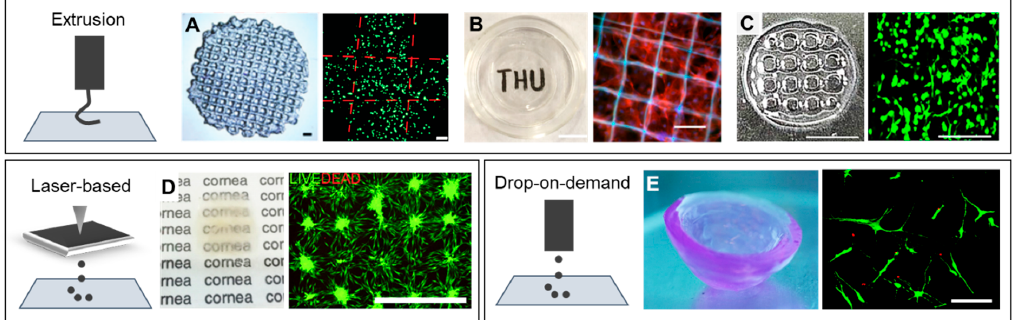
Figure 3. Cellular morphology in bioprinted corneal stromal tissue-like structures strongly depends on the material used as bioink. ( A ) Extrusion bioprinting of human corneal stromal keratocytes (CSKs) in 15% GelMa. Fluorescent staining shows round cells after bioprinting. Scale bars represent 1 mm (left) and 100 µ m (right) [88]. ( B ) Extrusion bioprinting of rat limbal stromal stem cells in PEG-PCL reinforced 15% GelMa. Fluorescent staining shows cellular filopodial extensions up to 50 µ m. Scale bars represent 10 mm (left) and 100 µ m (right) [87]. ( C ) Extrusion bioprinting of human